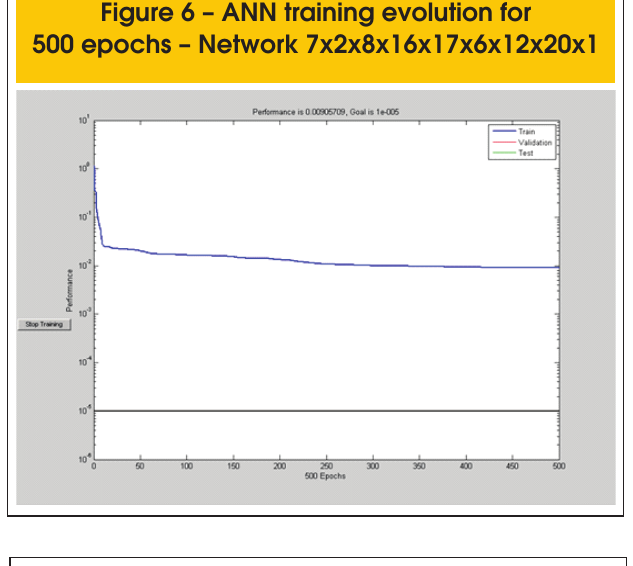
Figure 7 – ANN training evolution for 10,000 epochs – Network